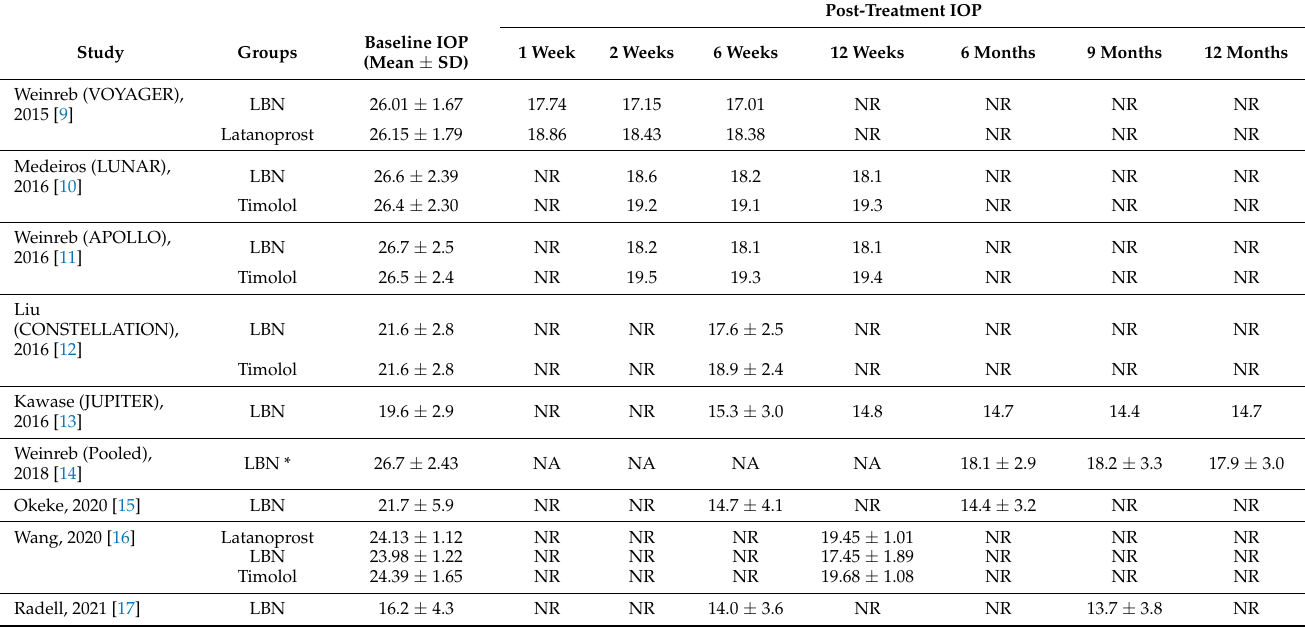
Table 2. IOP at baseline and post-treatment